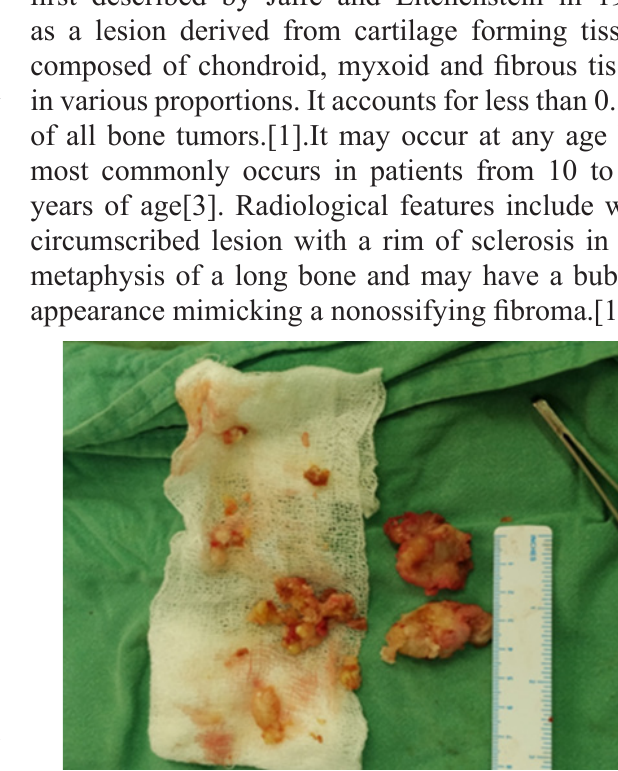
Fig 4: Intra operative picture after complete excision of the